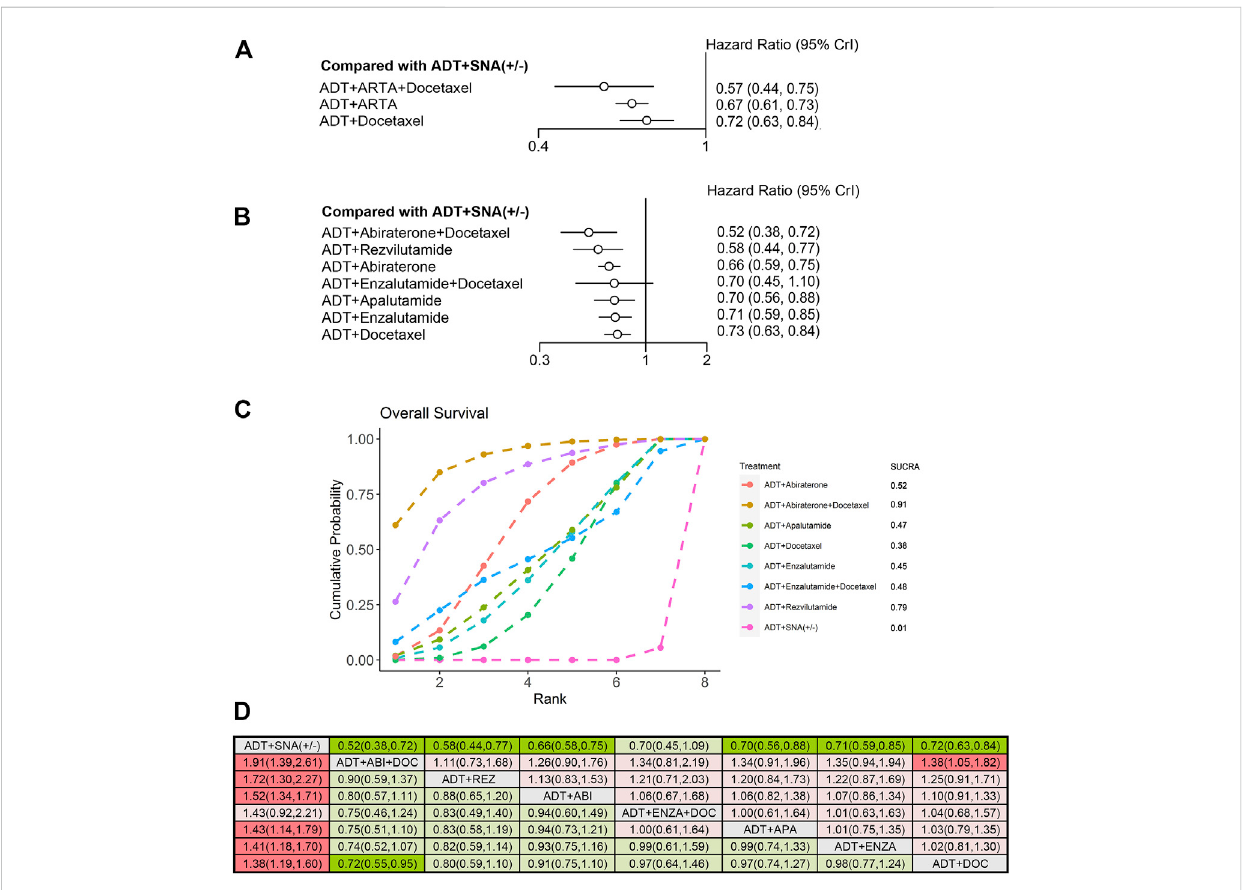
FIGURE 4 Comparison oftherapiesforimprovingOSinpatientswithhigh-volumedisease. (A) Forestplotrepresenting HRforcombinationtherapycompared with ADT with or without SNA. (B) Forest plot representing HR for speci fi c therapy compared with ADT with or without SNA. (C) SUCRA plot showing the treatment ranking of speci fi c therapies. (D) League table of NMA comparing the OS. Comparison is located at the intersection of the column-de fi ning treatment and the row-de fi ning treatment. The results are presented in HR with 95% CrI. HR > 1 (red) favors row-de fi ning treatment, and HR < 1 (green) favors column-de fi ning treatment. The dark red or green represents the results with statistical signi fi cance. DOC, Docetaxel; ABI, Abiraterone, ENZA, Enzalutamide; APA, Apalutamide; REZ, Rezvilutamide; OS, overall survival; ADT, androgen deprivation therapy; SNA, standard non-steroidal antiandrogen; HR, hazard ratio; NMA, network meta-analysis; SUCRA, surface under the cumulative ranking